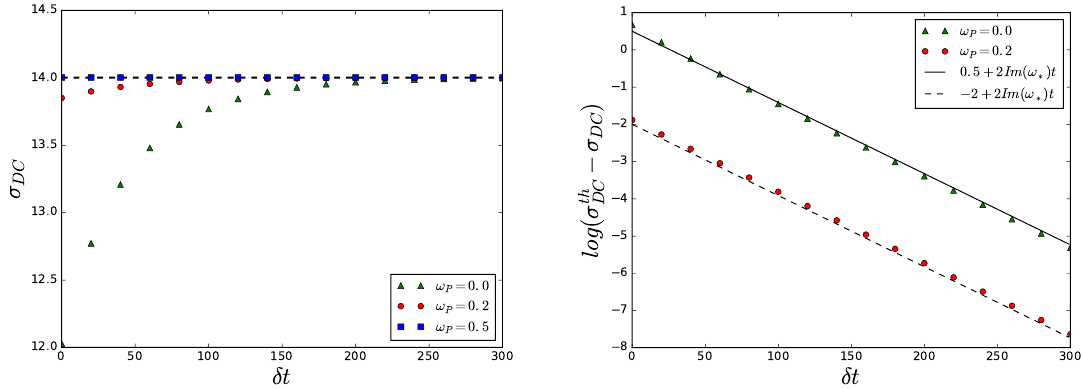
Figure 11 . The DC conductivity as a function of